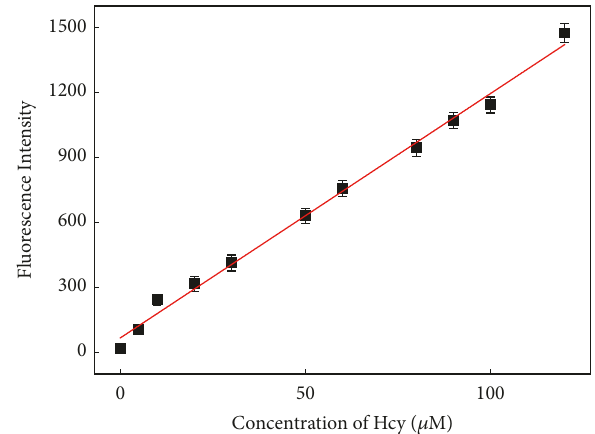
Figure 2: Changes of fluorescence intensity at 467 nm as the concentration increased of